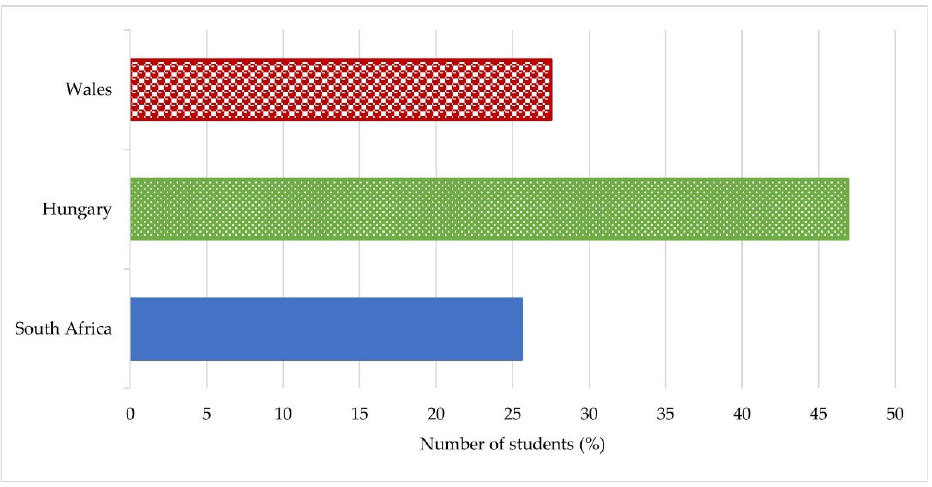
Figure 10. Students participating in the study by country (%). Most respondents (95%) were undergraduates studying toward a variety of degrees. Only a few, 4.1%, postgraduates participated in the study (Figure 11).